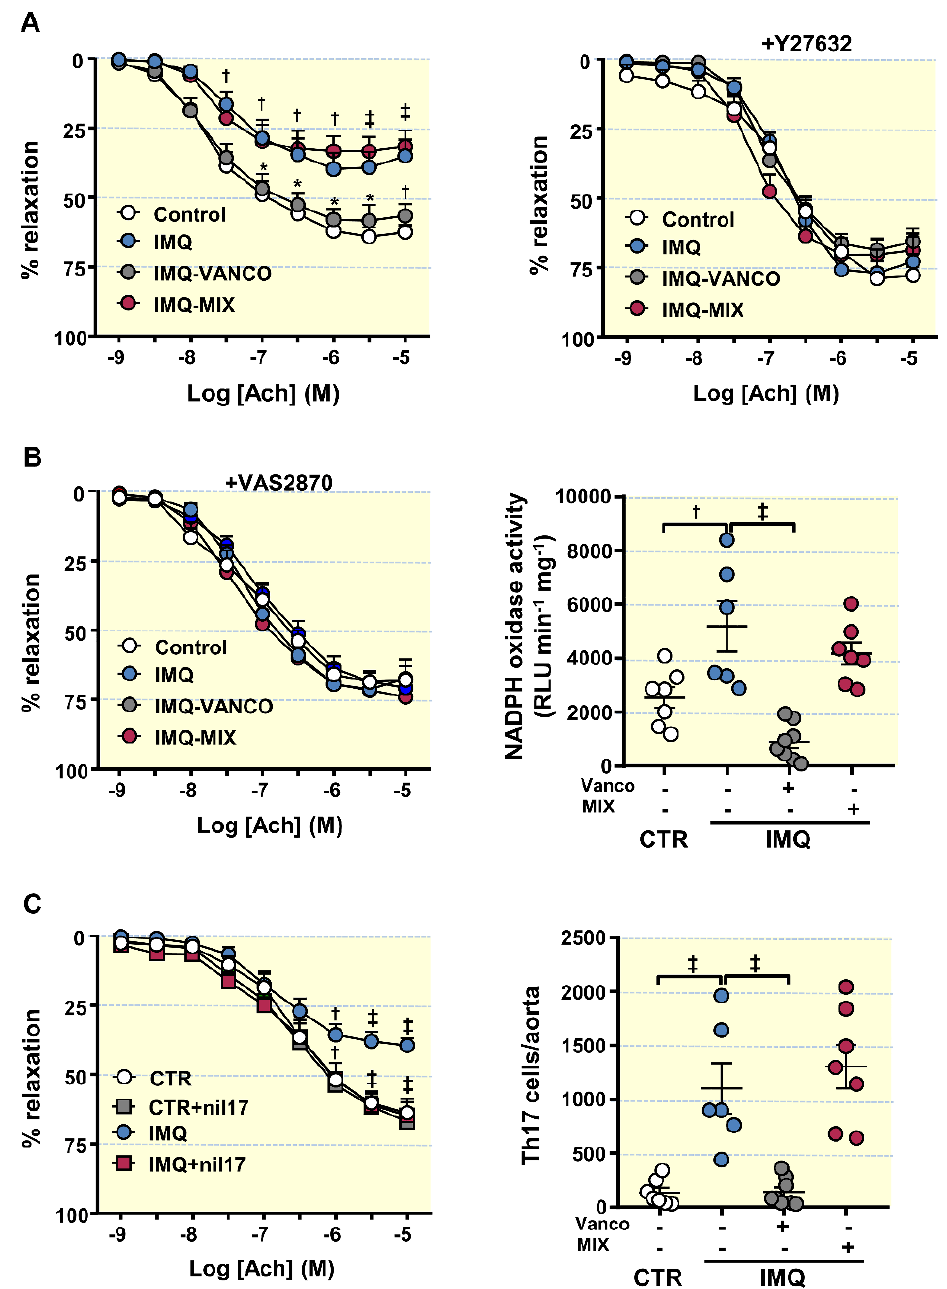
. Figure 4. Effects of treatment with antibiotics on SLE-linked endothelial dysfunction, NADPH oxidase activity and immune cell aorta infiltration in imiquimod (IMQ) mice. ( A ) Acetylcholine (Ach)-induced relaxation responses in aortas pre-contracted by U46619 (10 nM), with or without the Rho kinase inhibitor Y27632 (1 µ M); control (CTR), IMQ and IMQ-groups treated with Vancomycin (VANCO) or our cocktail of antibiotics (MIX). ( B ) Aortic responses induced by Ach in the absence or in the presence of the specific pan-NOX inhibitor VAS2870 (1 µ M) and aortic NADPH oxidase activity determined using a lucigenin-enhanced chemiluminescence. ( C ) Aortic responses induced by Ach in the absence or in the presence of anti-IL-17a antibody (10 µ g · mL) and aortic infiltration of Th17 assessed with flow cytometry. Data is represented as means ± SEM. The concentration-response curves to Ach were analysed by two-way ANOVA with the Tukey’s multiple comparison test. The rest of the variables were tested with one-way ANOVA and Tukey post hoc test. † p < 0.01, ‡ p < 0.001 in comparison with CTR; * p < 0.05, † p < 0.01, ‡ p < 0.001 in comparison with IMQ. Hierarchical cluster analysis (according distance measure using Pearson test correla- tion and clustering algorithm using ward.D) represented as a heat map of the fifty most abundant bacterial genera detected among groups, showed clear separation of groups to cluster by BP and Th17 population in MLNs (Figure S8). We subsequently examined whether the enriched gut bacterial communities partake in Th17 polarization in MLNs and high BP-associated with TLR-7 activation.